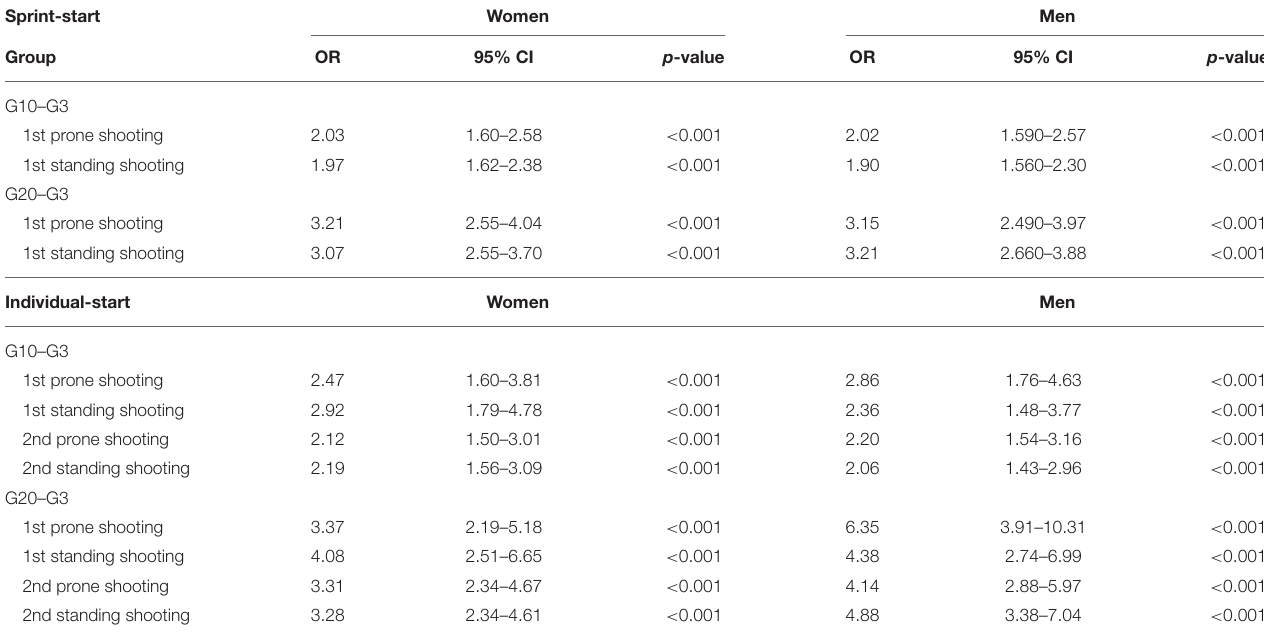
TABLE 4 | Multi-nominal logistic regression for missed targets in women’s and men’s sprint and individual competitions in IBU WC 2002/2003–2018/2019.